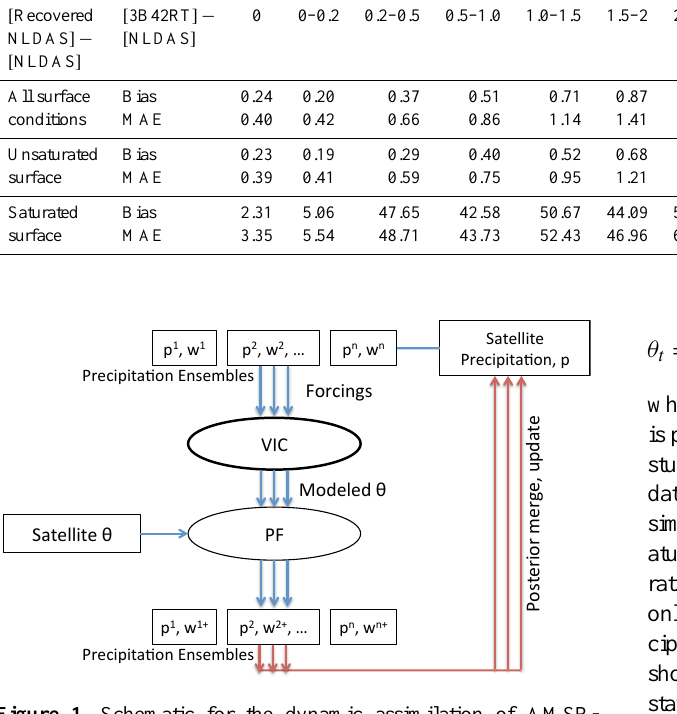
Figure 1. Schematic for the dynamic assimilation of AMSR- E/LSMEM (cid:49) SM into TMPA (3B42RT) with the particle filter